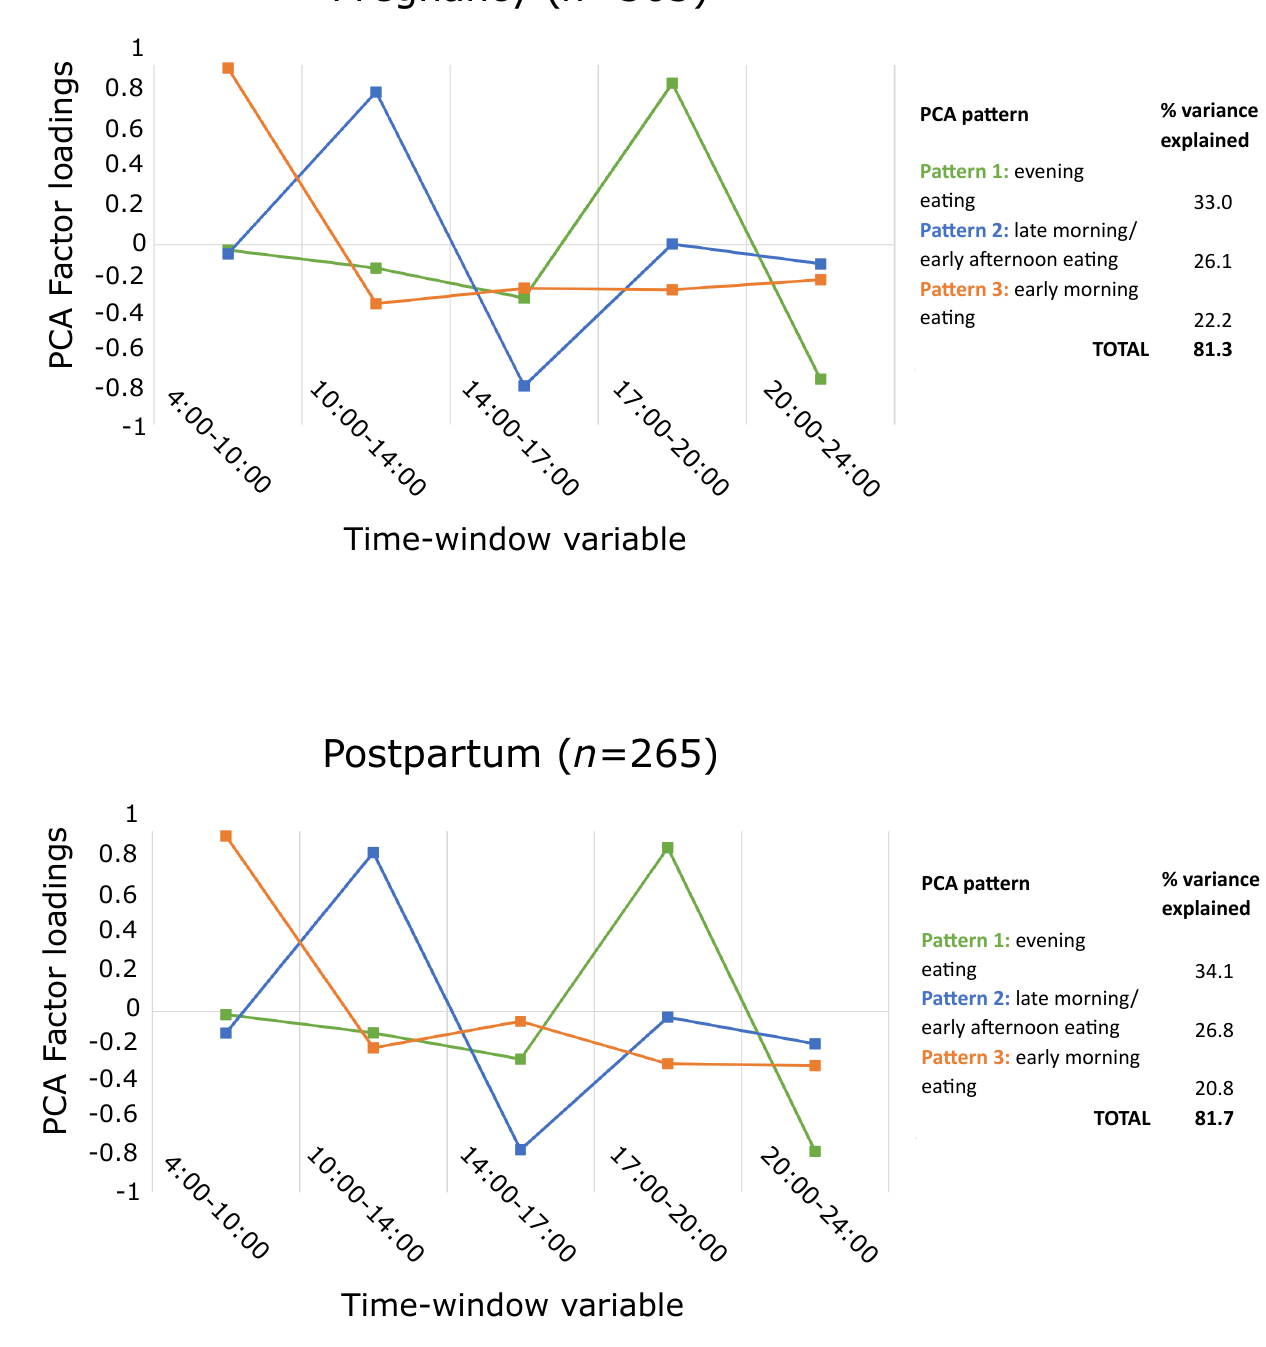
Figure 3. Identified PCA patterns for intake